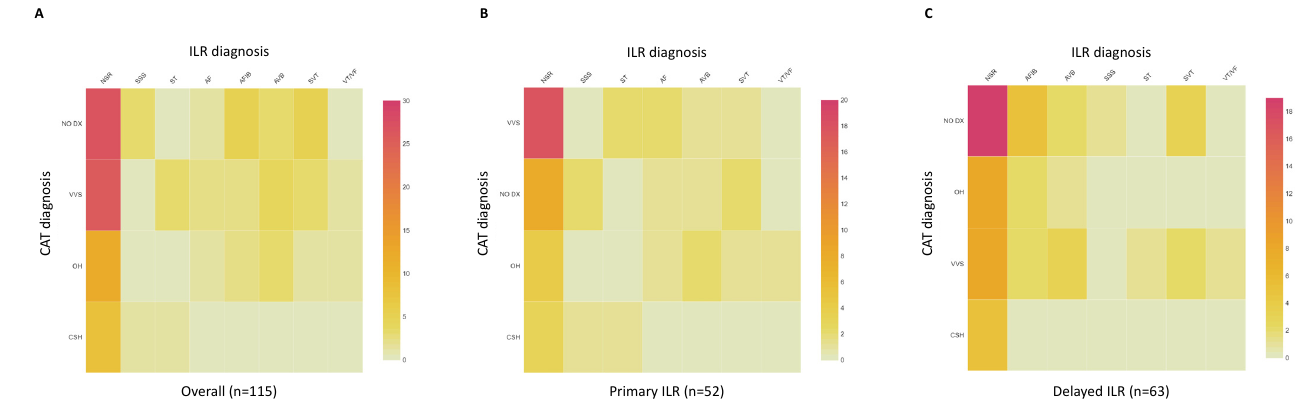
Figure 3. Heat map showing frequency of diagnosis by ILR and CAT: ( A ) overall population; ( B ) primary ILR subgroup; ( C ) post-CAT (delayed) ILR subgroup. AF, atrial fibrillation; AVB, atrioventricular block; CAT, cardiovascular autonomic testing; CSS, carotid sinus syndrome; ILR, implanted loop recorder; NSR, normal sinus rhythm; OH, orthostatic hypotension; SSS, sick sinus syndrome; ST, sinus tachycardia; SVT, supraventricular tachycardia; VT/VF, ventricular tachycardia/ventricular fibrillation; VVS, vasovagal syncope.